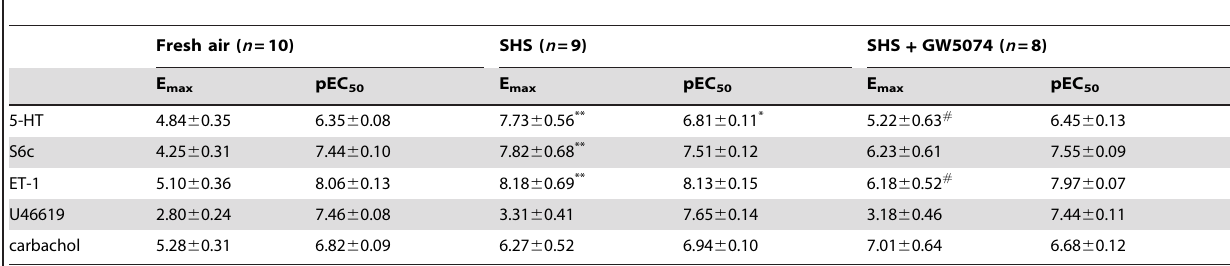
Table 1. E max and pEC 50 values of contractile responses induced by the receptor agonists.